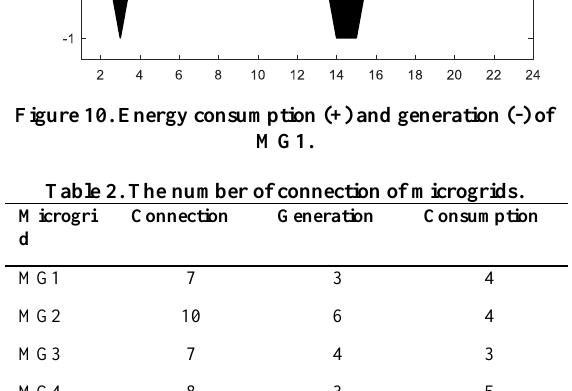
Figure 12. Charging Power of AEV.